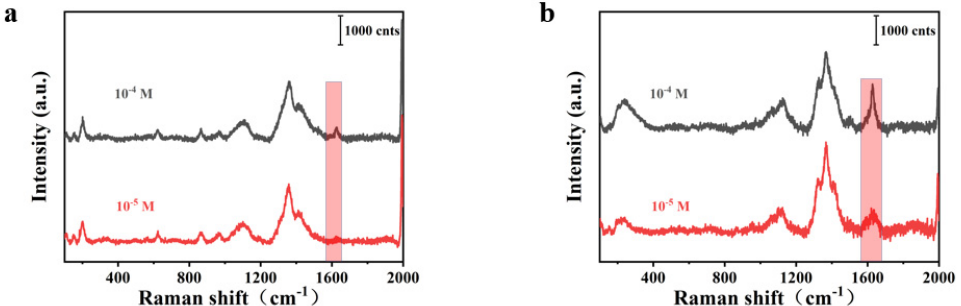
Figure 8. SERS spectra of the ( a ) pristine ( b ) treated Ag 2 NCN on MB.